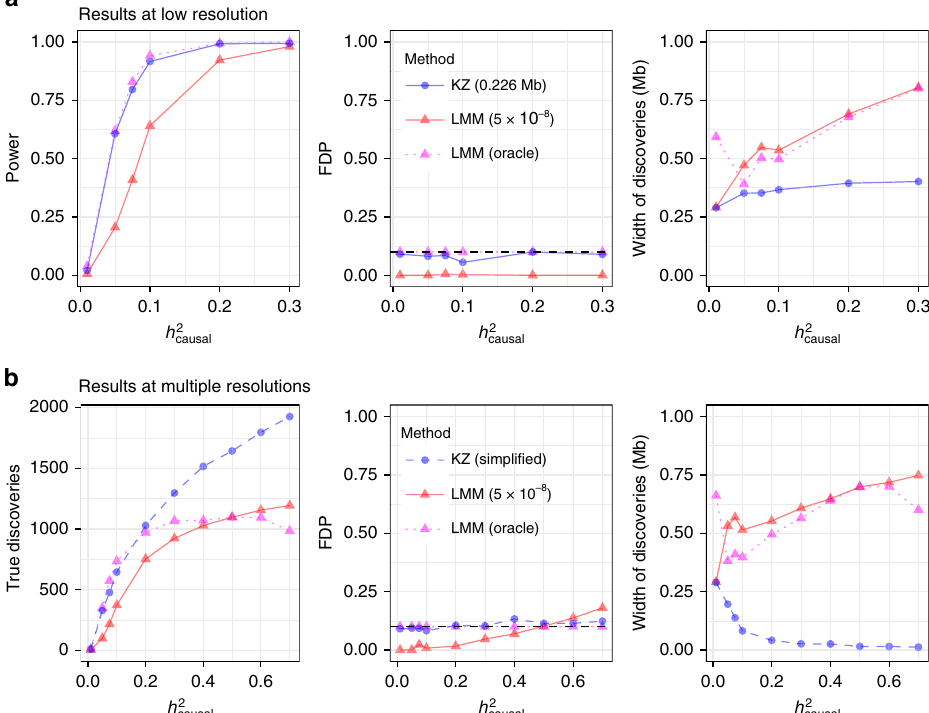
Fig. 3 Locus discovery in simulations. Locus discovery for a simulated trait with KnockoffZoom (nominal FDR 0.1) and BOLT-LMM (5 × 10 − 8 and oracle). a Low-resolution KnockoffZoom and strongly clumped LMM p values. b Multi-resolution KnockoffZoom (simpli fi ed count) and weakly clumped